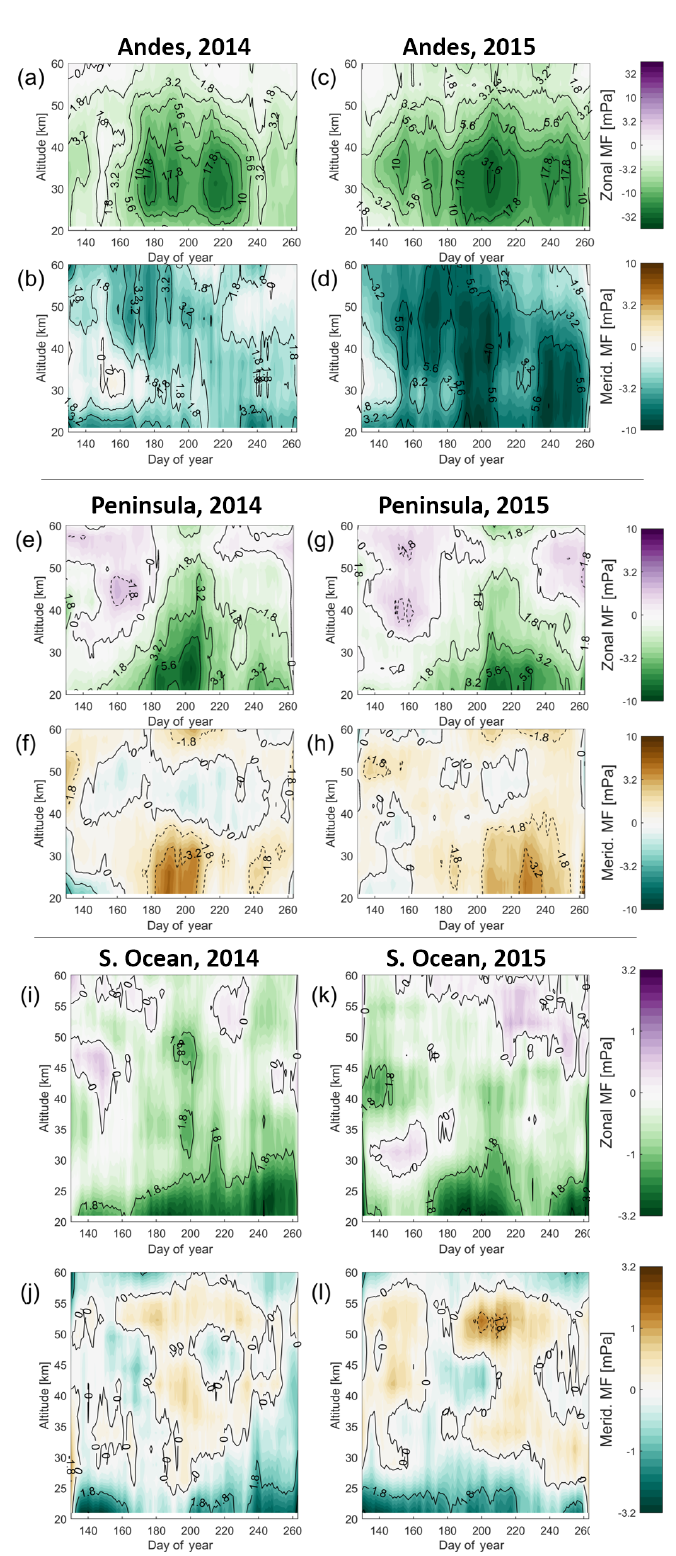
Figure 10. Time variability and directionality of measured MF for three geographic subregions and 2 years. Data are daily means boxcar- smoothed by 7 days. Note different scales for each